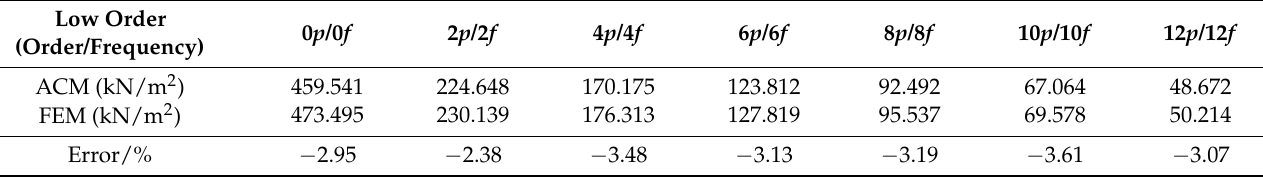
Table 7. Radial force density of main low order rated load.